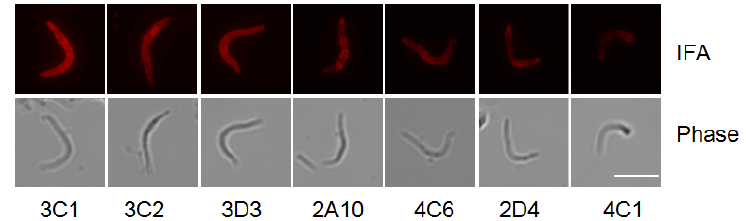
Figure 3. Immunofluorescence assays. PfCSP/Py (a P. yoelii parasite bearing P. falciparum circumsporozoite protein) salivary gland sporozoites [25] were incubated with 160 ng/mL mAbs, except 4C1 at 328 µ g/mL, followed by incubation with Alexa Fluor 594 goat anti-mouse IgG (H + L)